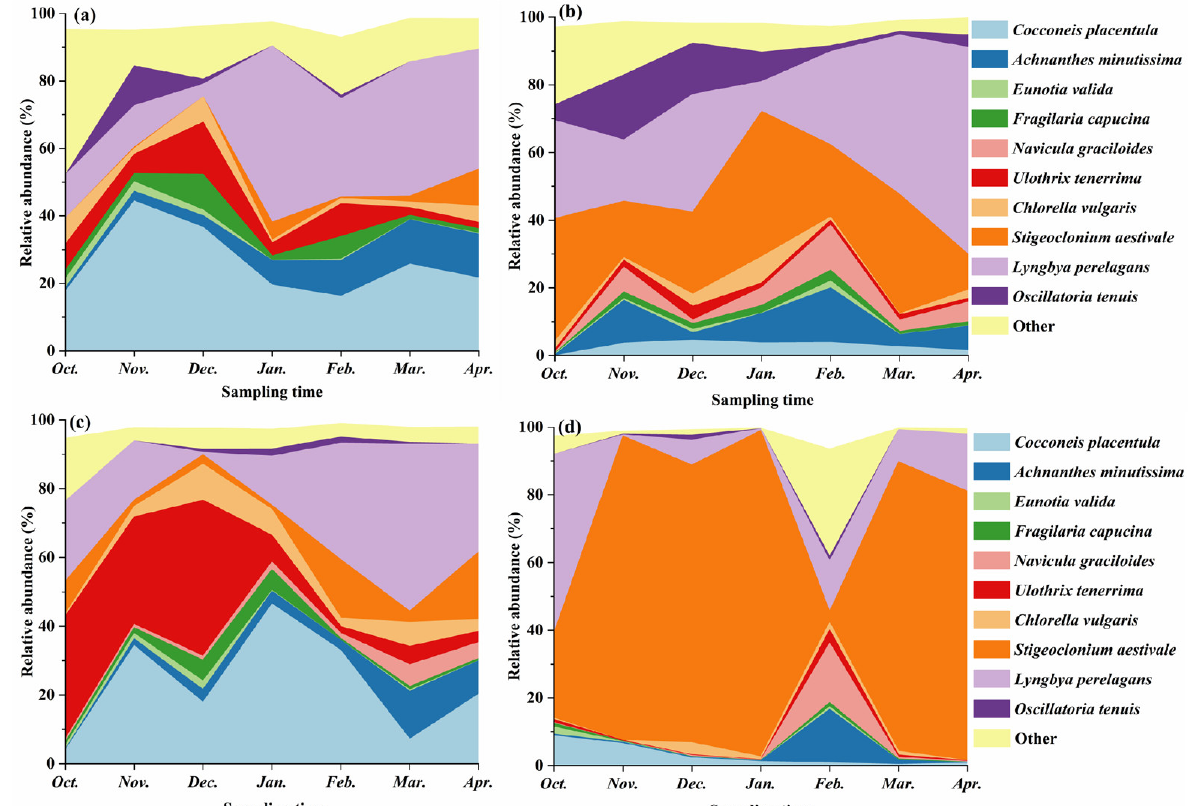
Figure 3. Relative abundance (%) of periphytic algae species on two different substrates in Maojiabu Lake and Xiaonanhu Lake: ( a ) periphytic algae on V. natans in Maojiabu Lake; ( b ) periphytic algae on artificial V. natans in Maojiabu Lake; ( c ) periphytic algae on V. natans in Xiaonanhu Lake; and ( d ) periphytic algae on artificial V. natans in Xiaonanhu Lake.